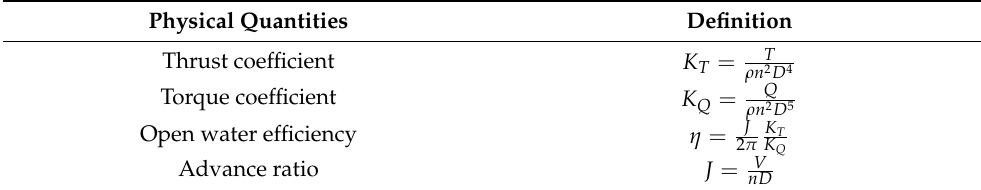
Table 4. Non-dimensional quantities of PJP.